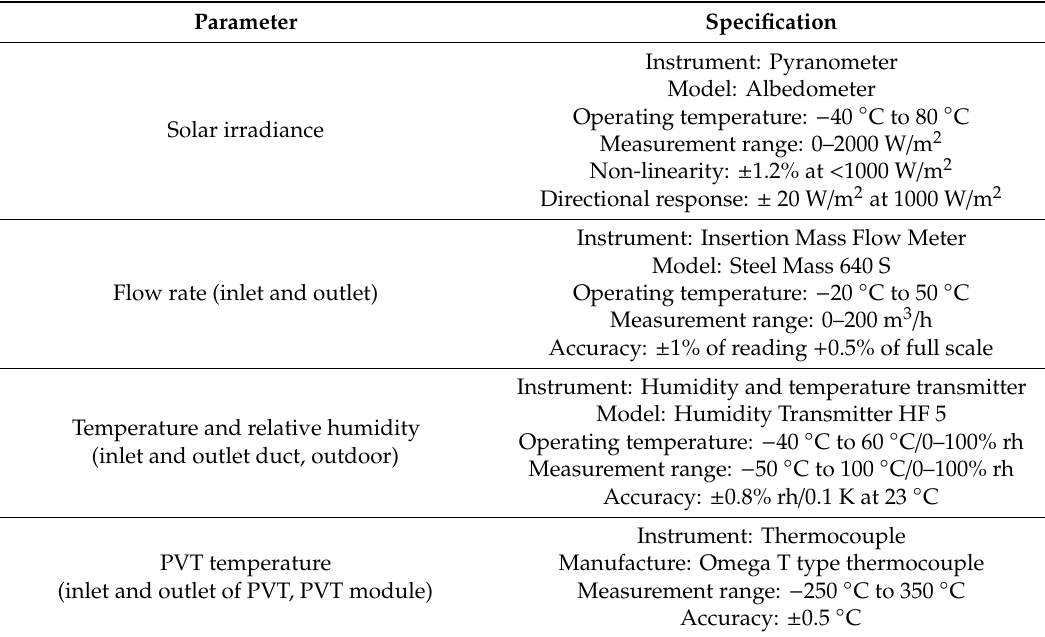
Table 3. Specifications of the measuring equipment.